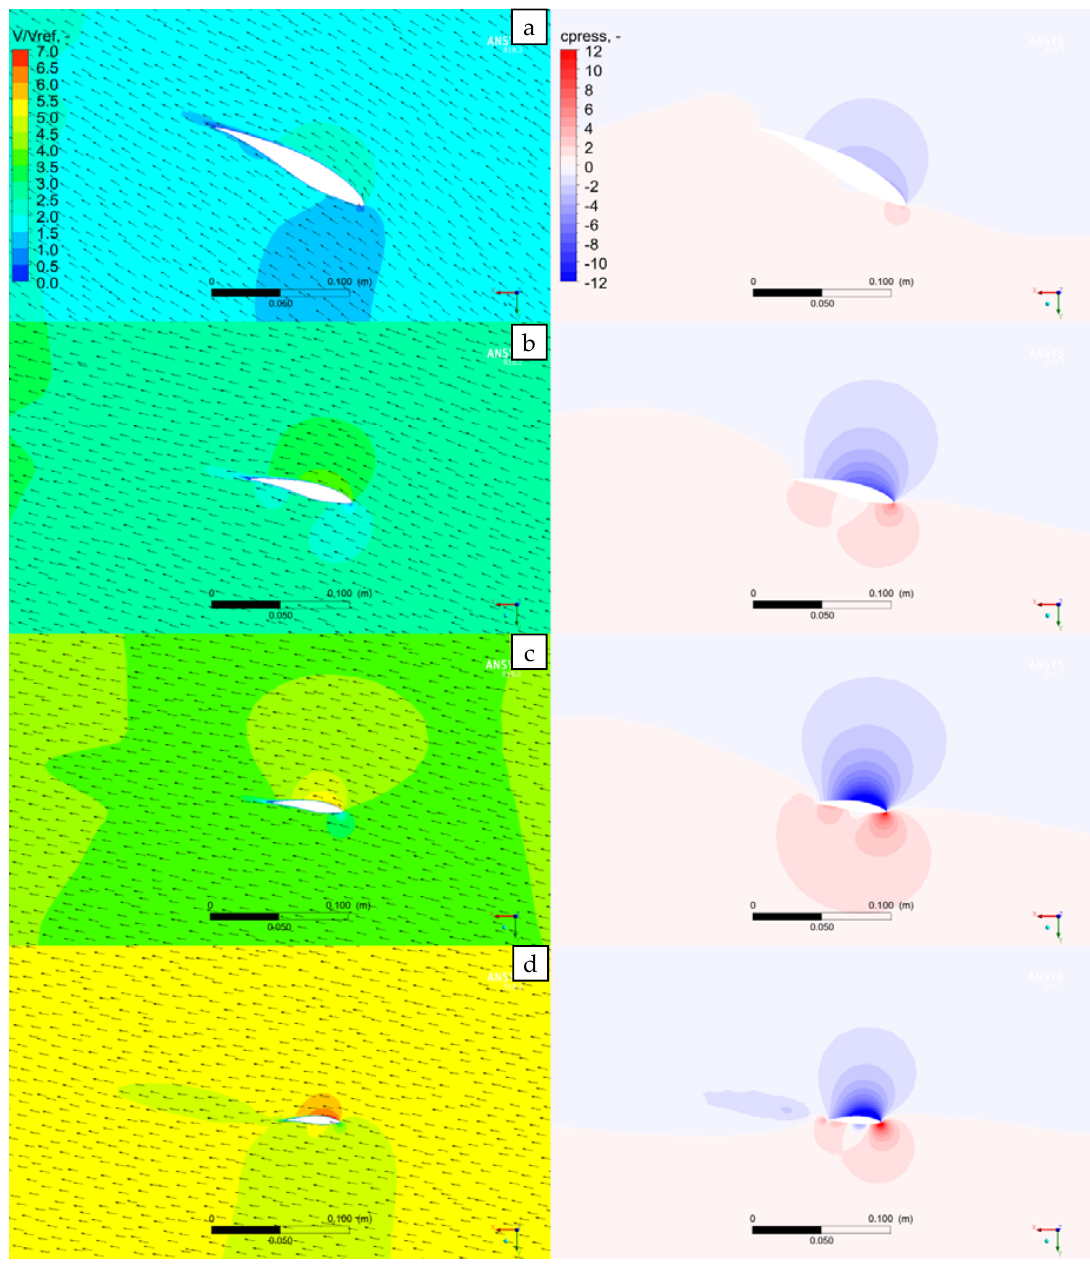
Figure 6. Normalized velocity ( Vref = 12 m/s, TSR = 5) contours and vectors (left) and pressure coefficient contours (right) at r / R equal to ( a ) 0.25, ( b ) 0.5, ( c ) 0.75, and ( d ) 0.9875.